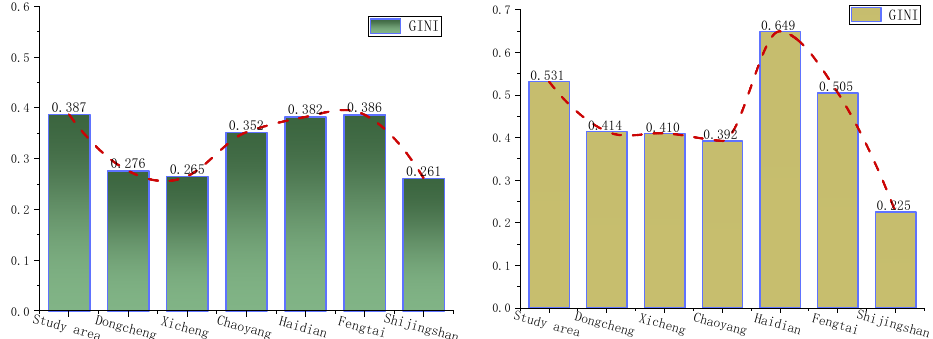
Figure 5. Gini coefficient of ground-average TPS ( left ) and Gini coefficient of per capita TPS ( right ).